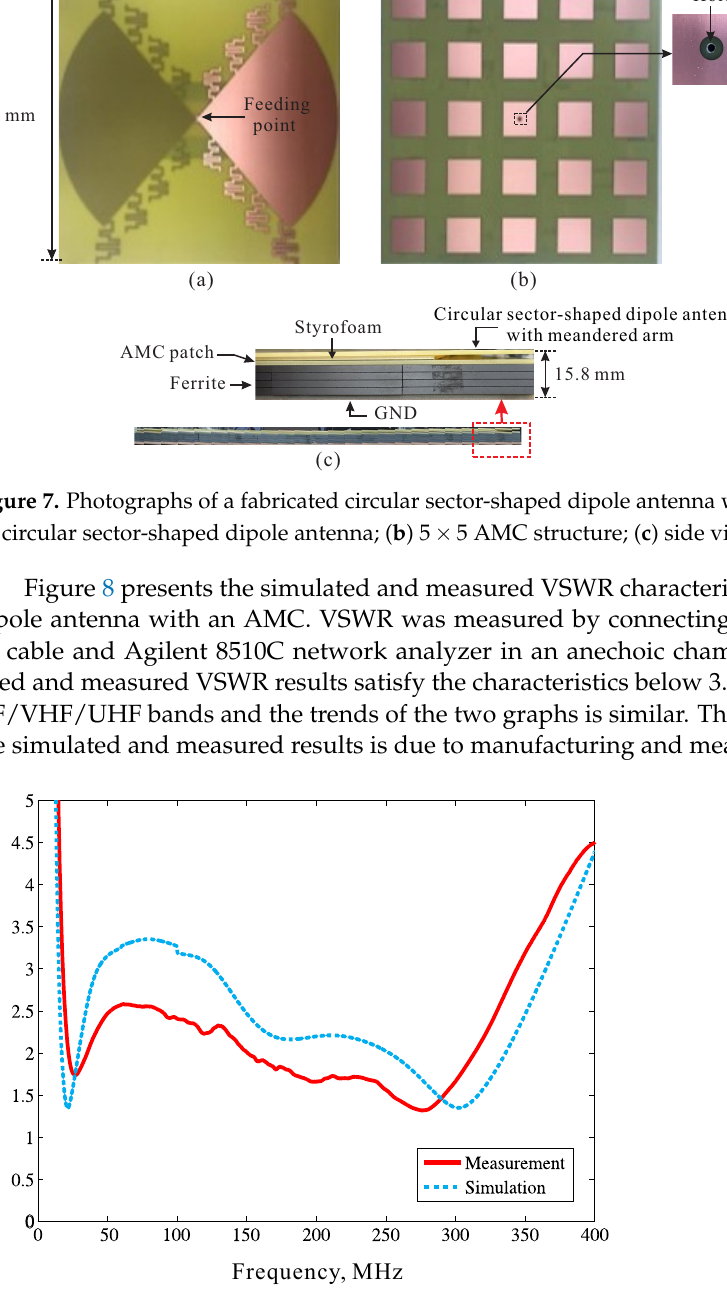
Figure 8. Simulated and measured VSWR characteristics of the proposed